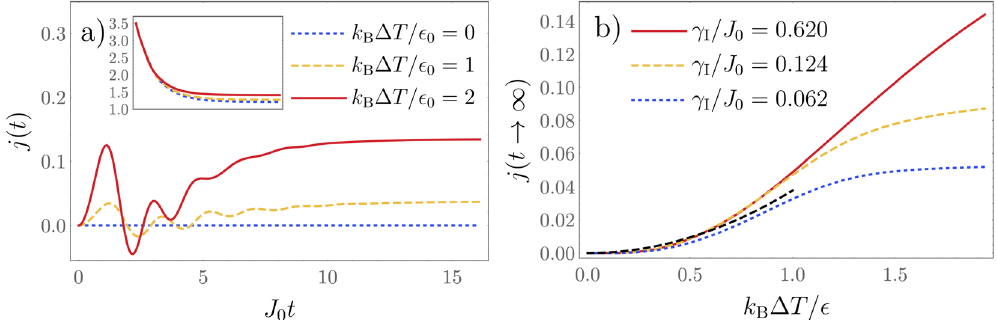
Fig. 6 Spin currents under the action of a spin pump. a Time evolution according to Eqs. (8) and (11) of the total spin current for different values of the temperature gradient with γ / J 0 = 3.102 and γ I / J 0 = 0.620. Here, γ is the loss rate of down spins at the edges (as in the previous plot) and γ I is the rate at which down spins are pumped into the system at the center ( k B is the Boltzmann constant, ϵ 0 is the energy per particle in the thermodynamic limit, J 0 = α 1 / g , where α 1 is the value of the exchange coef fi cients at T = 0 and g is the interaction strength). The inset shows time evolution of the total magnetization for the same set of parameters. b The amplitude of the steady-state current as a function of the temperature gradient for different choices of γ I . The black dashed curve shows a quadratic fi t for k B Δ T / ϵ 0 < 1. All presented quantities are